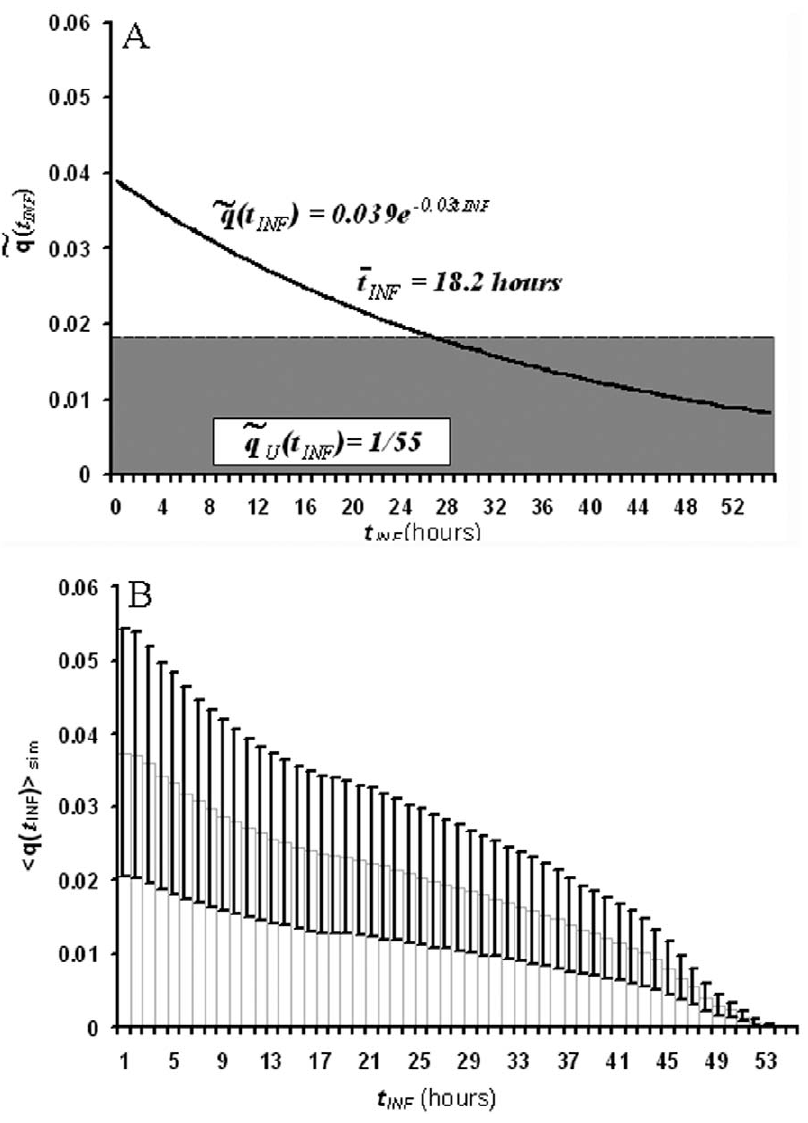
Figure 5. Expected and simulated distributions of post-invasion times q t INF ð Þ . A) Expected theoretical distributions obtained from the optimization of system’s diversity. Grey solid distribution: assuming a uniform distribution of IRBCs. Black line: imposing a fixed observed post- invasion time t INF ~ 18 : 2 hours . B) Simulated average distribution of post-invasion times S q t INF ð Þ T among the population of IRBCs in a static culture set from a rather synchronous inoculum ( (cid:2) tt INF 0 ð Þ ~ 24 hours ) with sub-cultivation carried out every two days. Error bars indicate the standard deviation s S q t INF ð Þ T observed through 15 days in culture under the stationary regime.